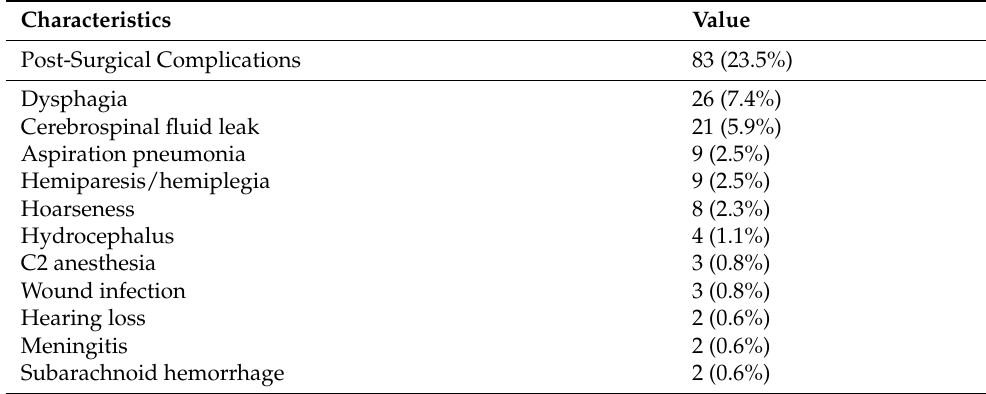
Table 4. Summary of treatment